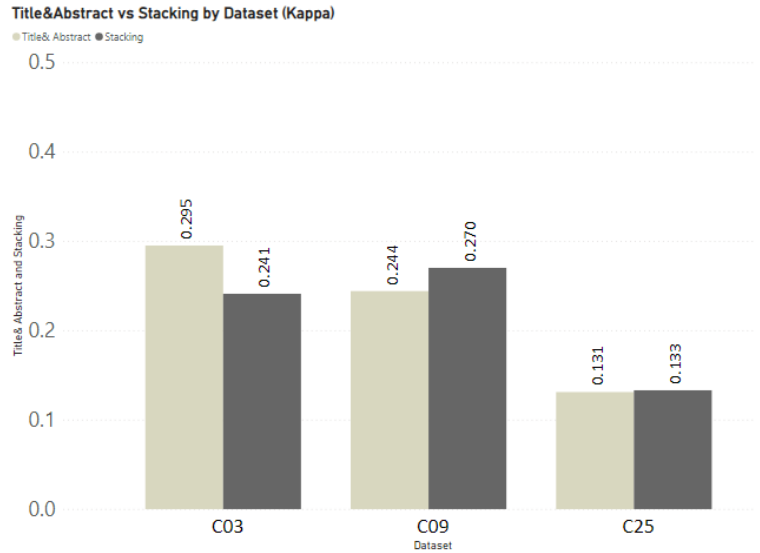
Figure 7. Kappa values of the OHSUMED datasets where the statistical difference between Stacking– TA models cannot be tested.